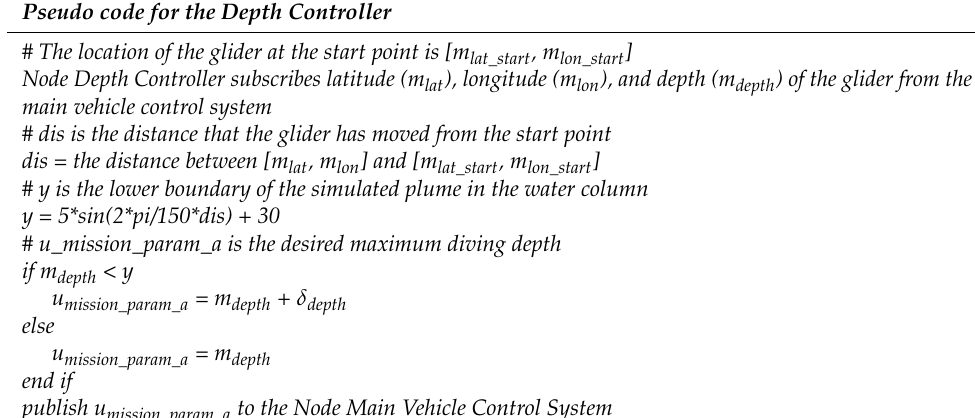
Table 3. Control algorithm of a depth controller for backseat control when the glider changes its depth based on a simplified fluorescence field.